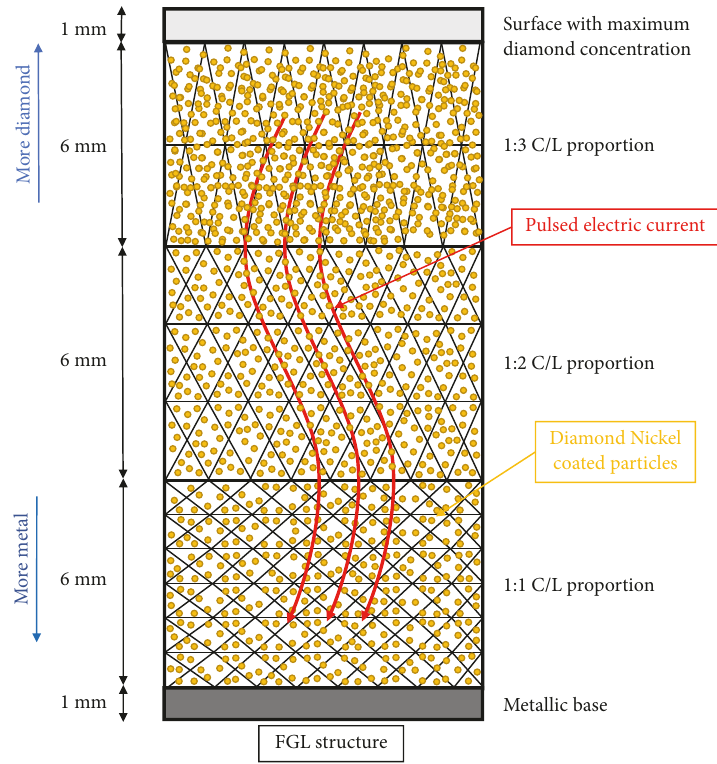
Figure 2: Schematic of material with FGL structure (during preparation before SPSing). Table 1: Composition of samples and SPS sintering